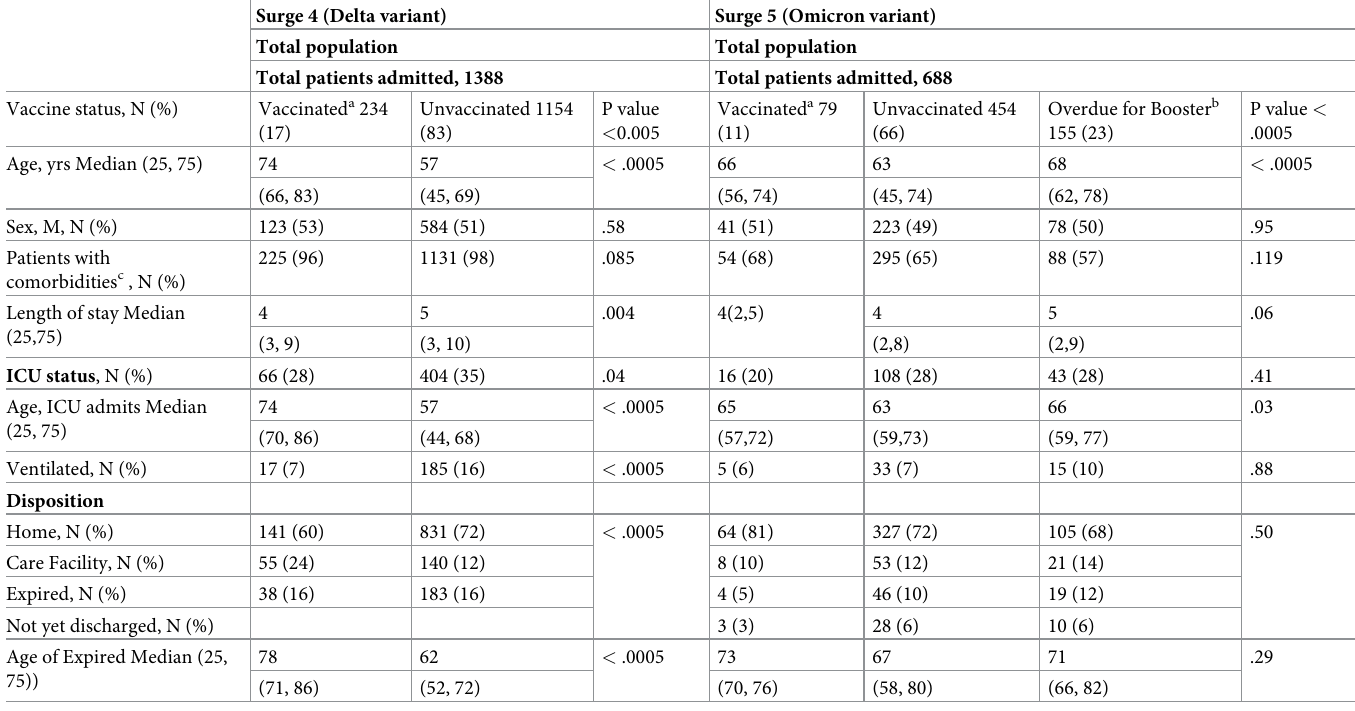
Table 2. Adults � 18 Delta and Omicron surge data by vaccine